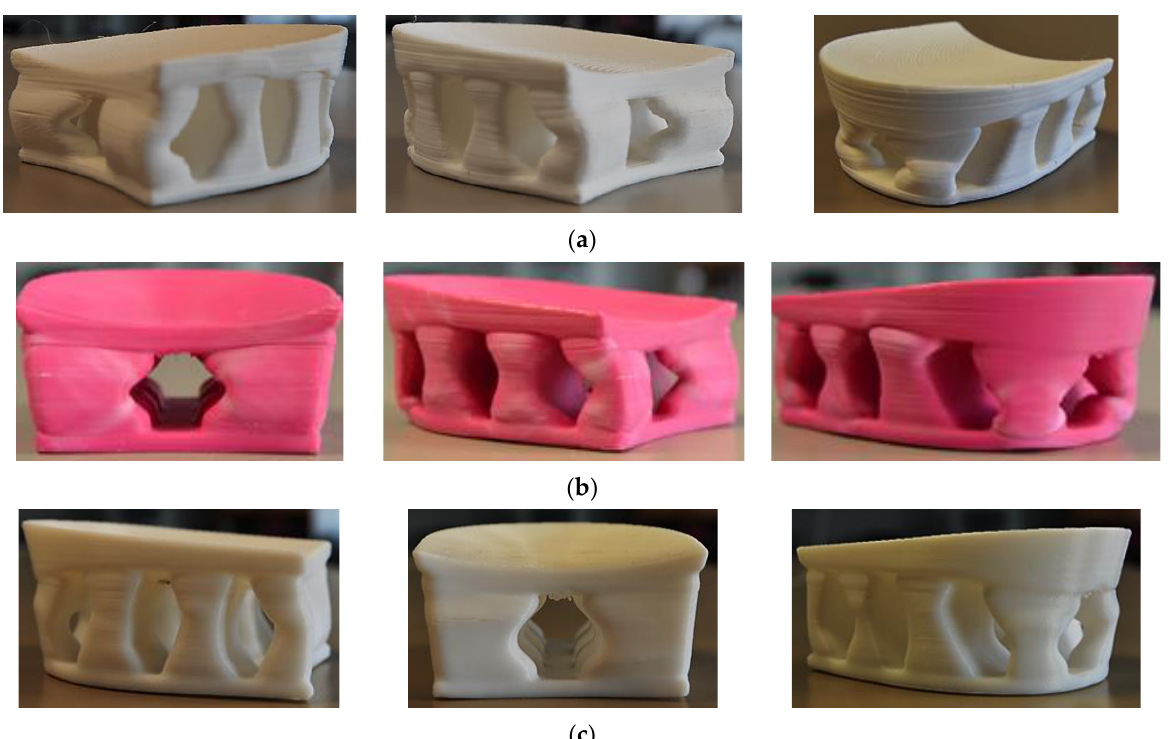
Figure 10. The samples of FDM-printed heel prototypes after compression test: ( a ) heels from PLA; ( b ) heels from ABS; ( c ) heels from PA (NYLON).